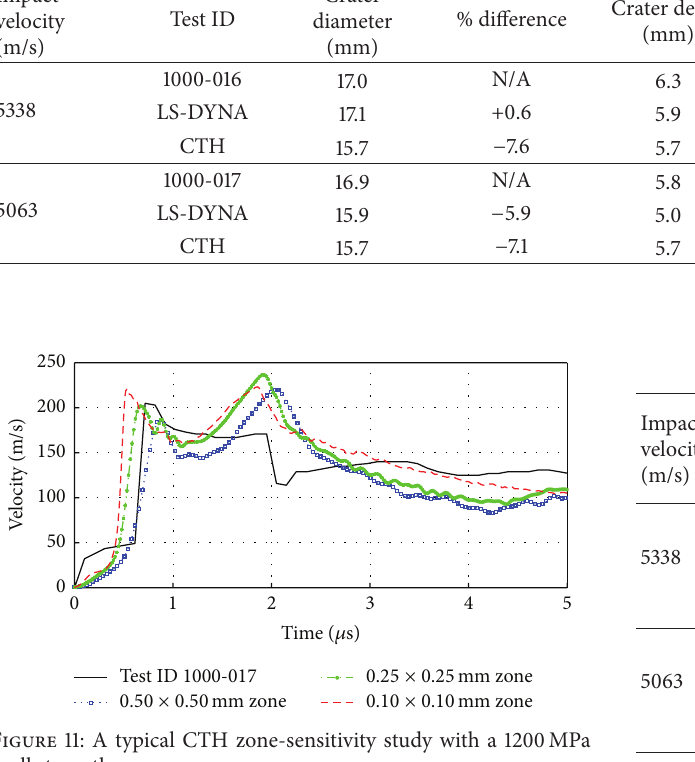
Figure 11: A typical CTH zone-sensitivity study with a 1200 MPa spall strength.